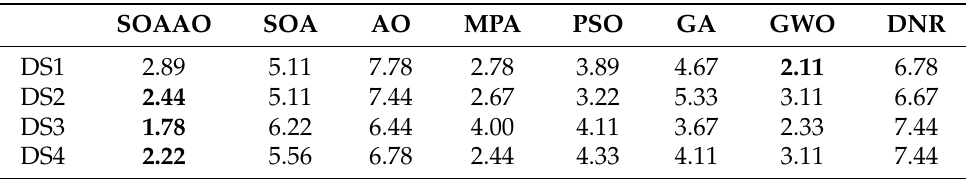
Table 7. The results of Friedman